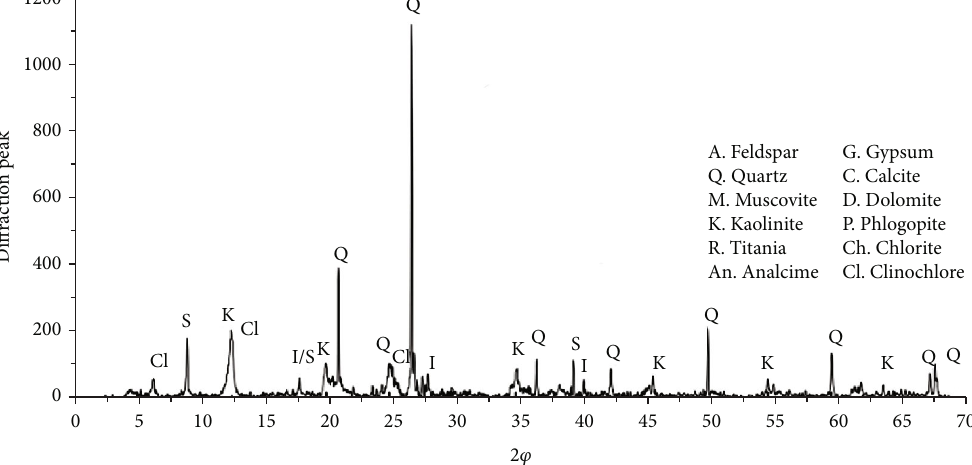
Figure 3: X-ray di ff raction analysis of argillaceous weakly cemented rock.